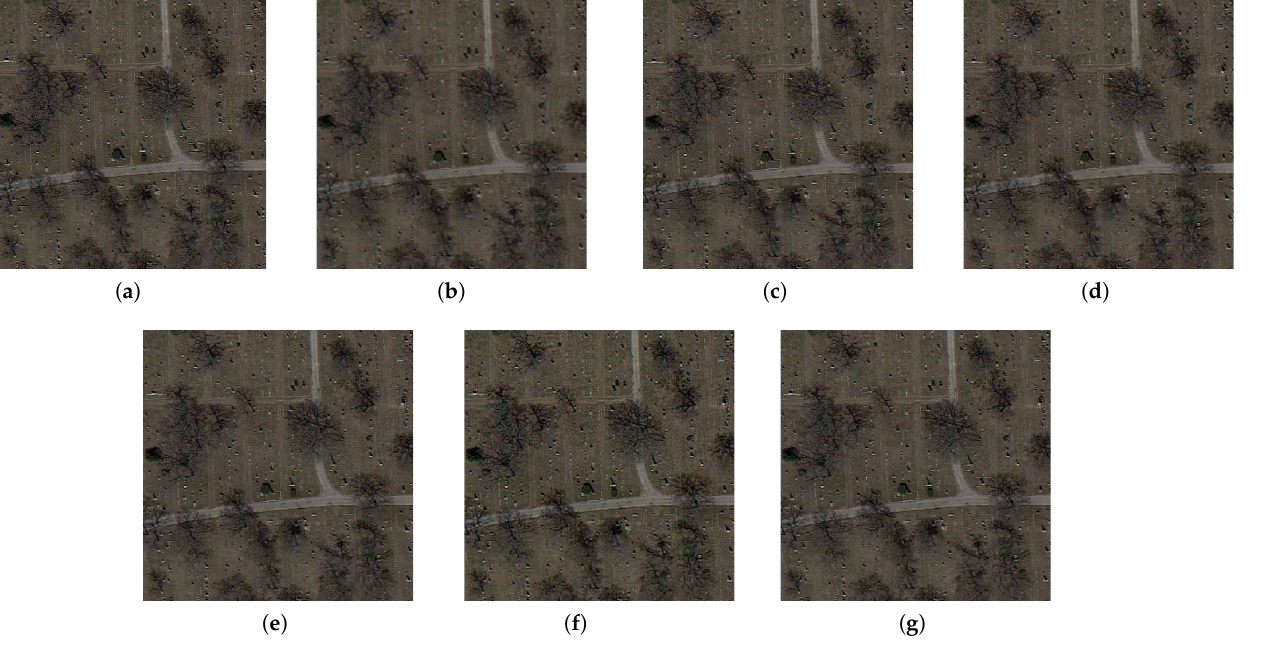
Figure 14. Comparison of visual results of different SR methods with × 2 super-resolution on the RSC11 [44] dataset (sparse forest scene). ( a ) HR. ( b ) Bicubic. ( c ) EDSR [68]. ( d ) RCAN [81]. ( e ) RDN [64]. ( f ) SAN [83]. ( g ) NLSN